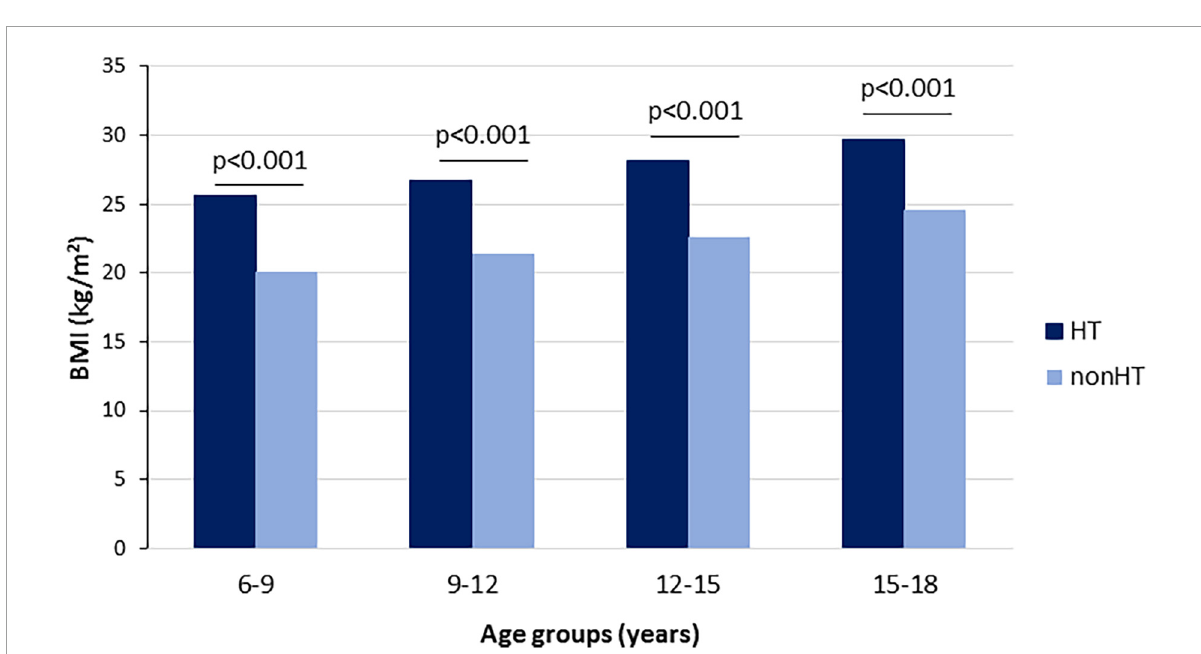
FIGURE3 Average body mass index (BMI) values in children with and without hypertension in different age